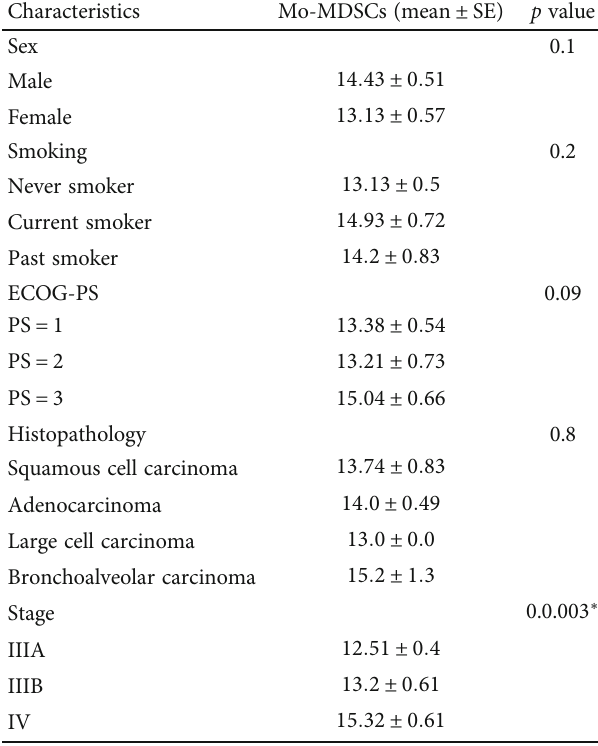
Table 3: Relation of Mo-MDSCs to di ff erent clinical